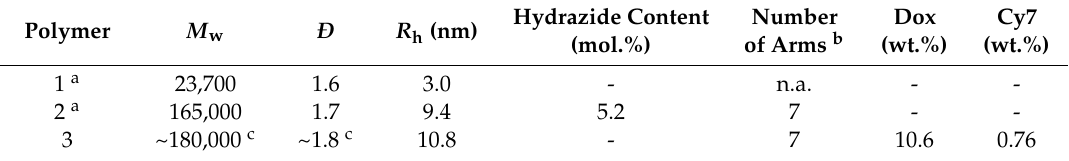
Table 1. Characteristics of polymer precursors and polymer 3, designated as pHPMA-Dox-Cy7 conjugate.